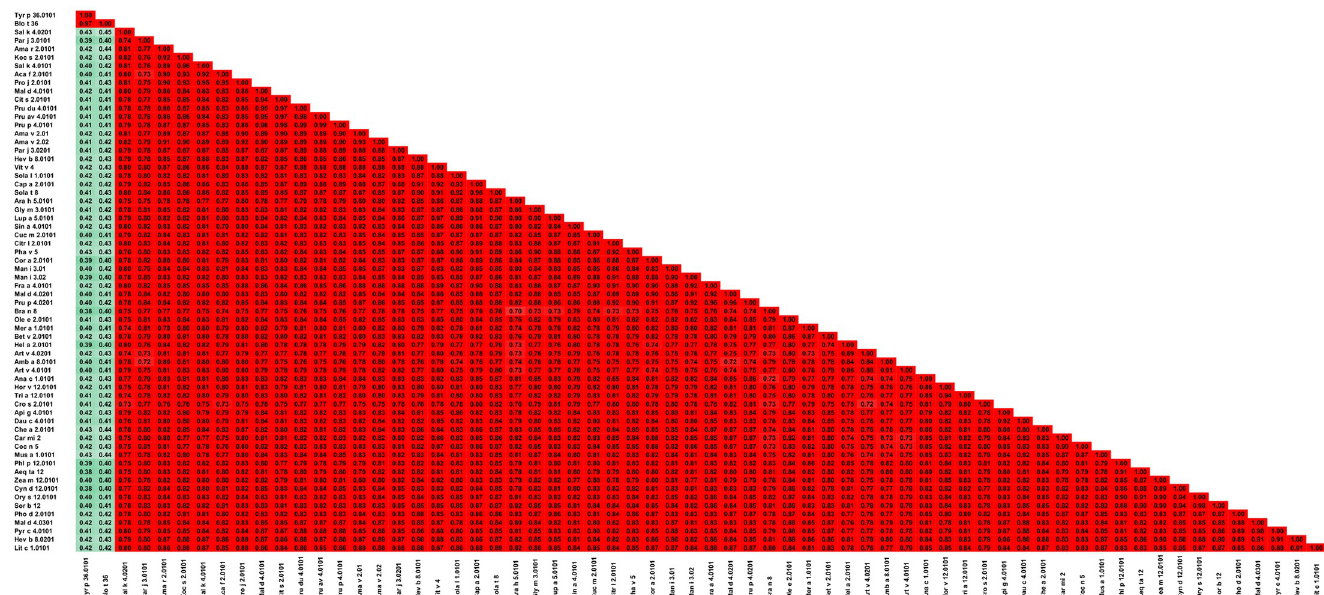
Fig 19. Plot showing A-RISC index values for allergen pairs from profilin family of proteins. Red color indicates a high risk of cross-reactivity, a dark green color indicates a low risk of cross-reactivity, and intermediate colors correspond to a medium risk of cross-reactivity.